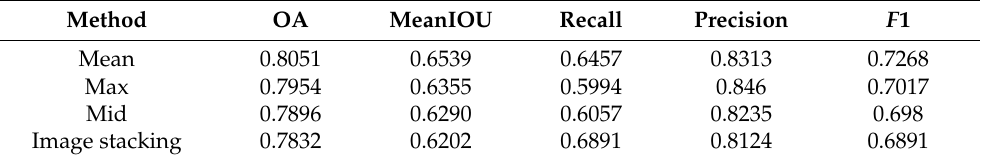
Figure 13. The results of multitemporal synthesis methods. ( a – c ) are the original images on 16, 28 September and 10 October 2019; ( d ) Ground truth; ( e – h ) are results obtained by using mean synthesis, maximum synthesis, median synthesis and image stacking in the time-phase dimension; ( i – l ) are corresponding prediction results for ( e – h ). Table 4. Quantitative assessment results of the comparison test for multitemporal synthetic in region